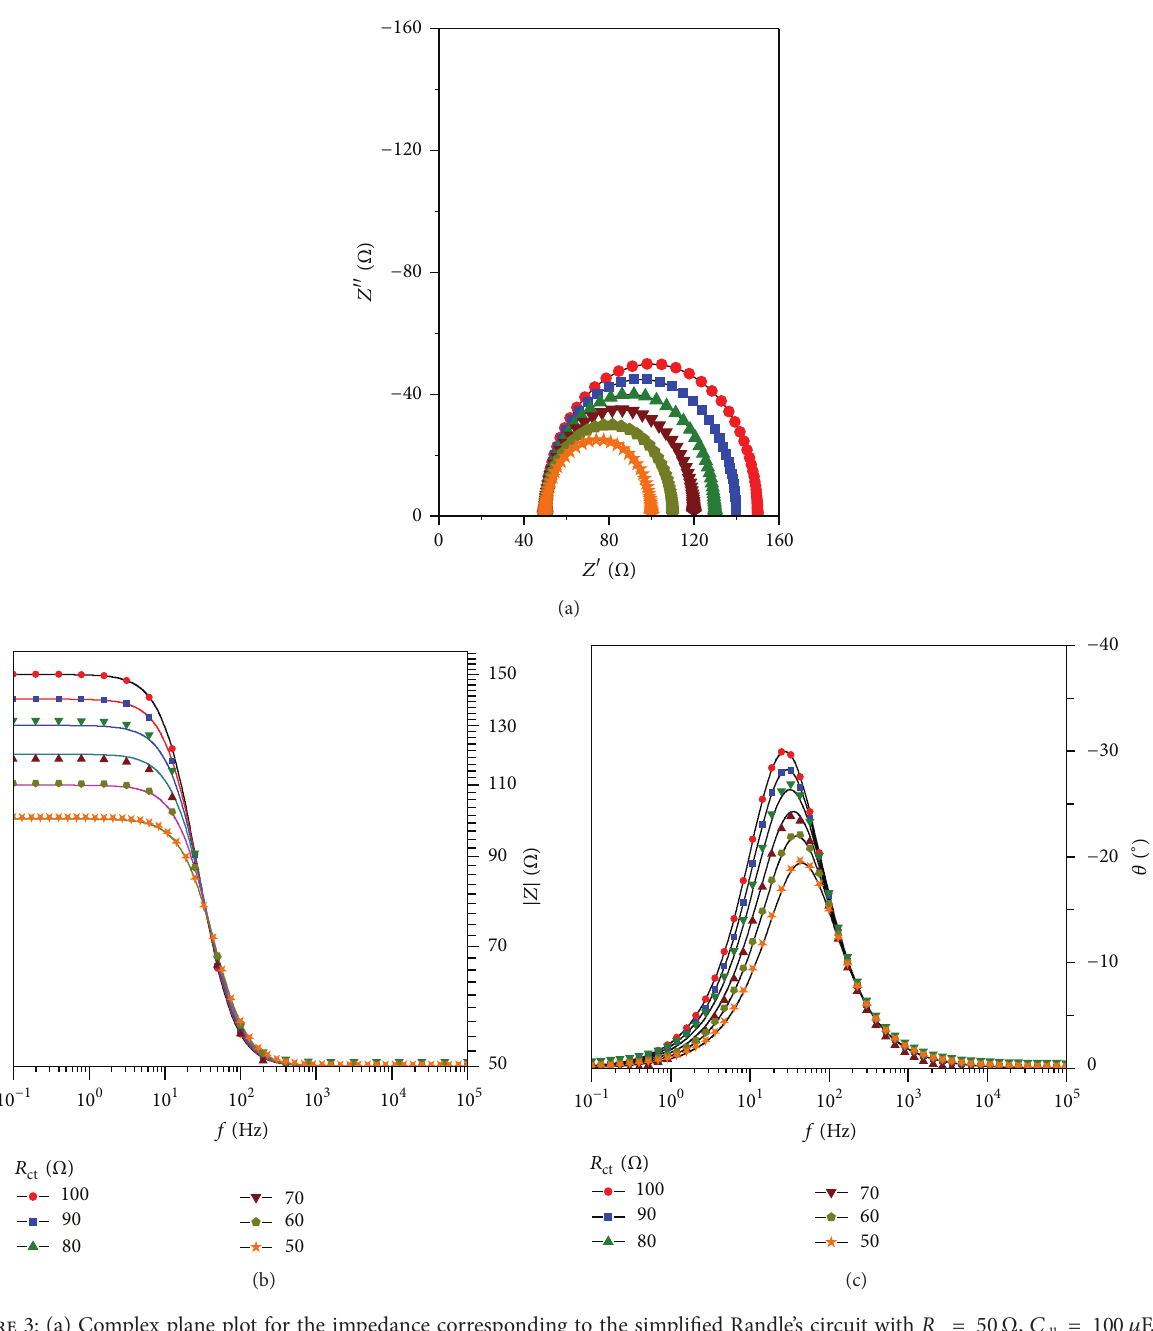
Figure 3: (a) Complex plane plot for the impedance corresponding to the simplified Randle’s circuit with 𝑅 𝑠 = 50Ω , 𝐶 as mentioned. (b) Bode magnitude and (c) phase plot for the different values of 𝑅 ct